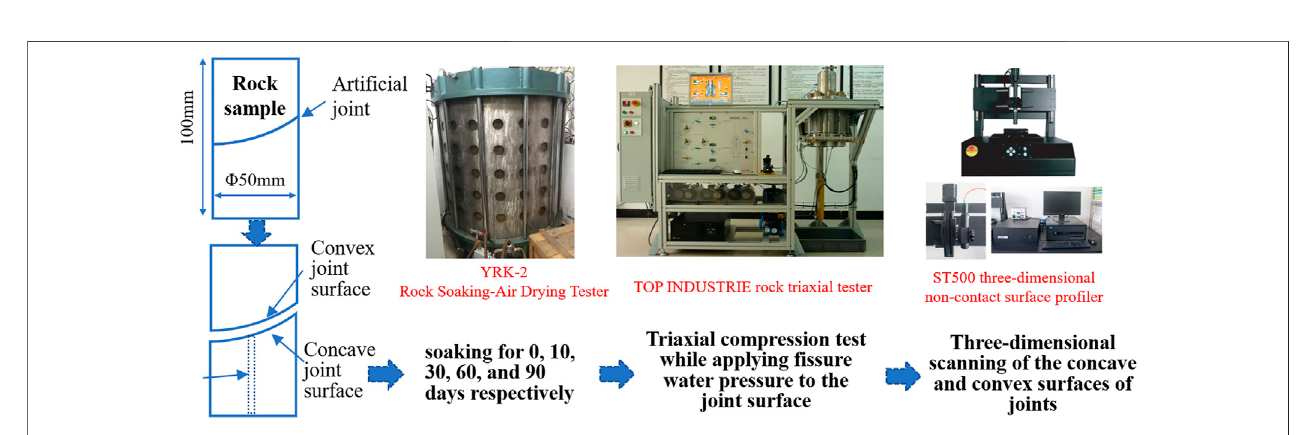
FIGURE 2 | Schematic diagram of sample and test